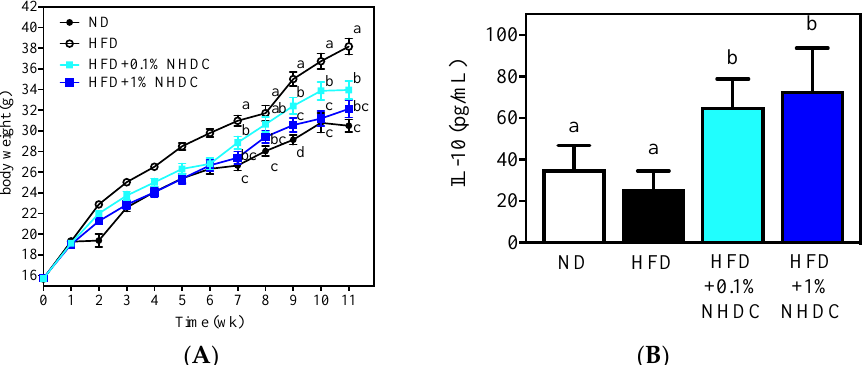
Figure 4. Body weight changes ( A ) and anti-inflammatory IL-10 secretion by M2-polarized BMDM of C57BL/6J male mice following 11 weeks of ad libitum dietary intervention (mean ± SEM, n = 10). a–c The different letters indicate statistical significance within the week ( A ) or the repeated experiment ( B ).